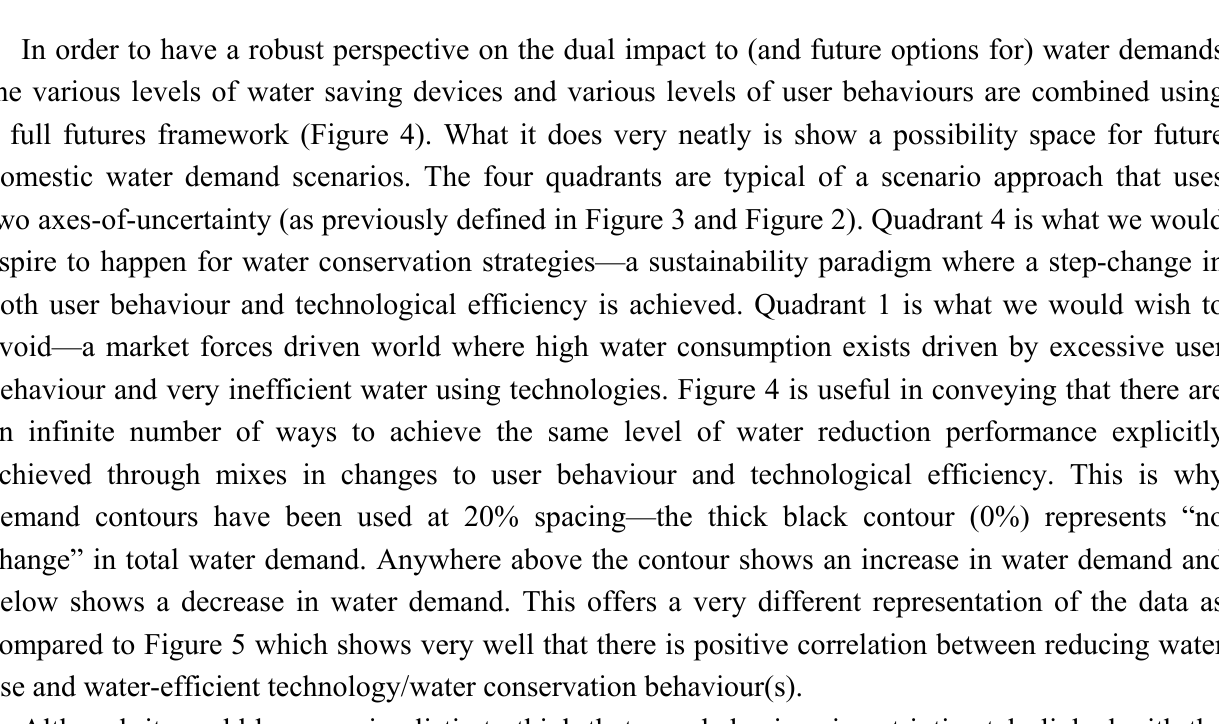
Table 9: In case Dc (11.2 L/employee/day) a smaller WC cistern, urinal and lower flow rate